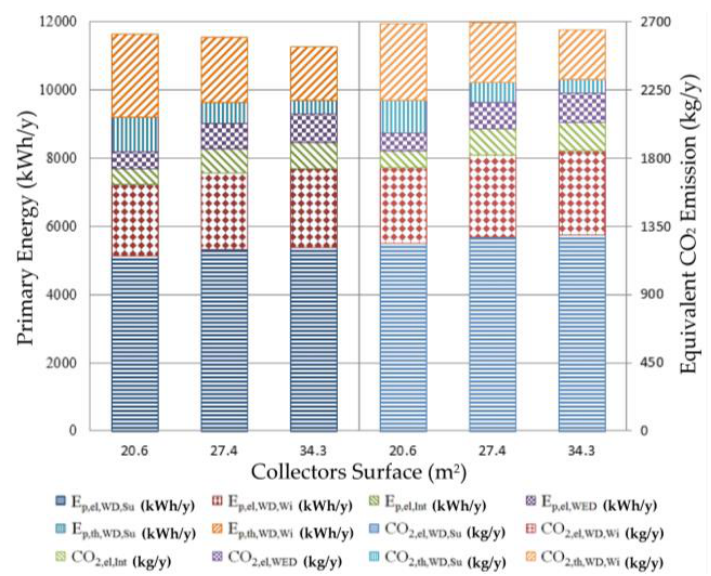
Figure 16. Annual primary energy consumption and equivalent CO 2 emission associated with seasonal electric and thermal demands for the plant with cross-flow heat recovery unit (Scenario C), evacuated tube collectors, tilt angle of 40° and 0% of solar thermal energy surplus used.